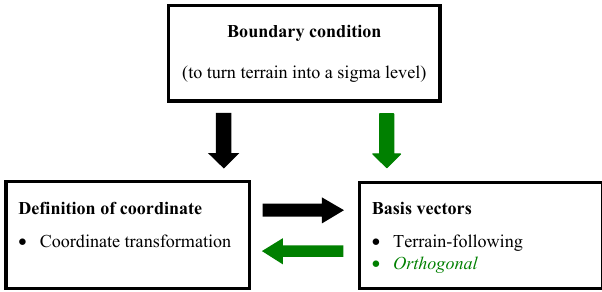
Figure 1. Design of the OS-coordinate. The green arrows are for the OS-coordinate, and the black arrows, the CS-coordinate.